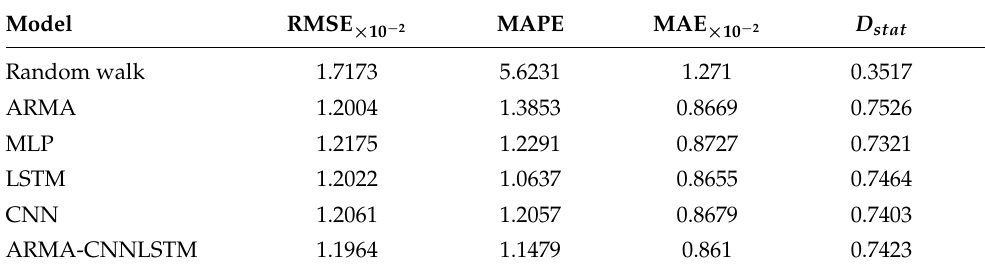
Table 3. Comparison of the predictive abilities of different models for Shanghai stock index time series. Model